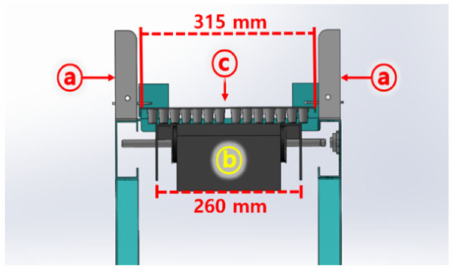
Figure 7. Lateral size of each component: ( a ) stopper bracket, ( b ) elevator plate, and ( c ) pot tray.